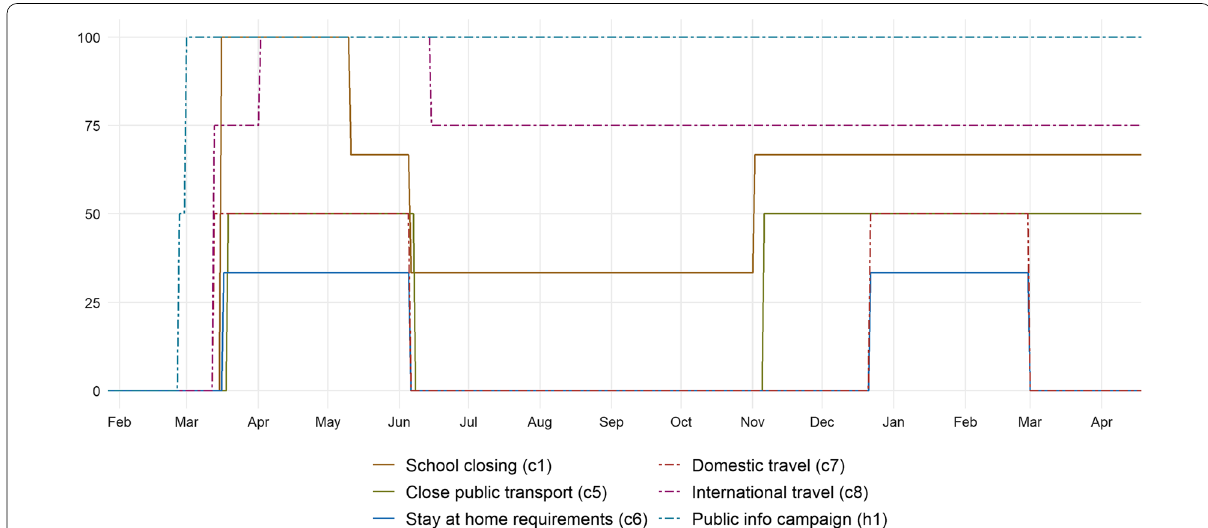
Fig. 12 Sub‑categories of the KSI + without cantonal variation. Graph shows the sub‑indicators of the KOF Stringency‑Plus Index that exhibit no cantonal variation. The respective sub‑indicator is denoted on the y ‑axis. Note that cantonal variation only starts end of June 2020. The first